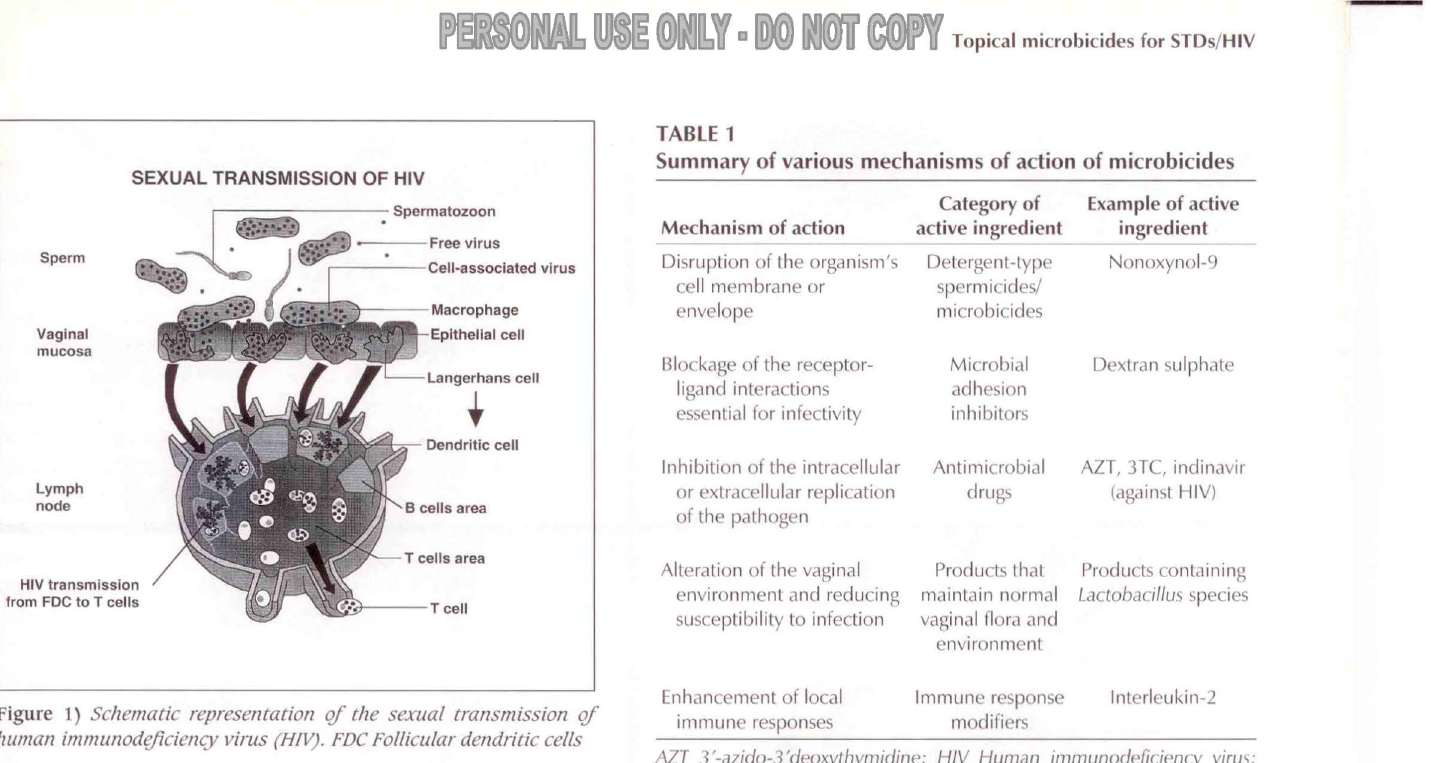
Figure 1) Schematic representation ef the sexual transmission ef human immunodeficienqy virus (HlV). FDC Follicular dendritic cells